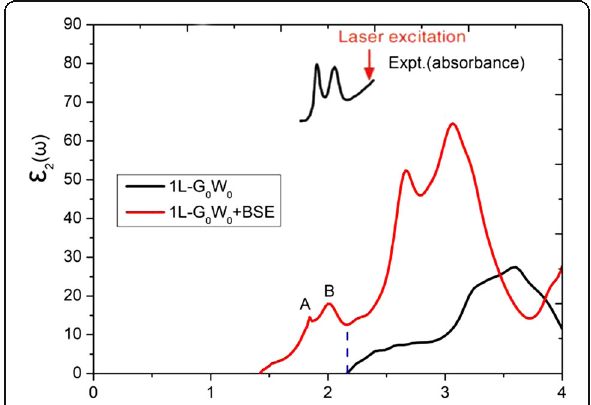
Fig. 1 The imaginary parts of the dielectric function for monolayer MoS 2 , by using the G 0 W 0 and G 0 W 0 +BSE methods, respectively. The experimental absorption spectrum for MoS 2 is extracted from Ref.